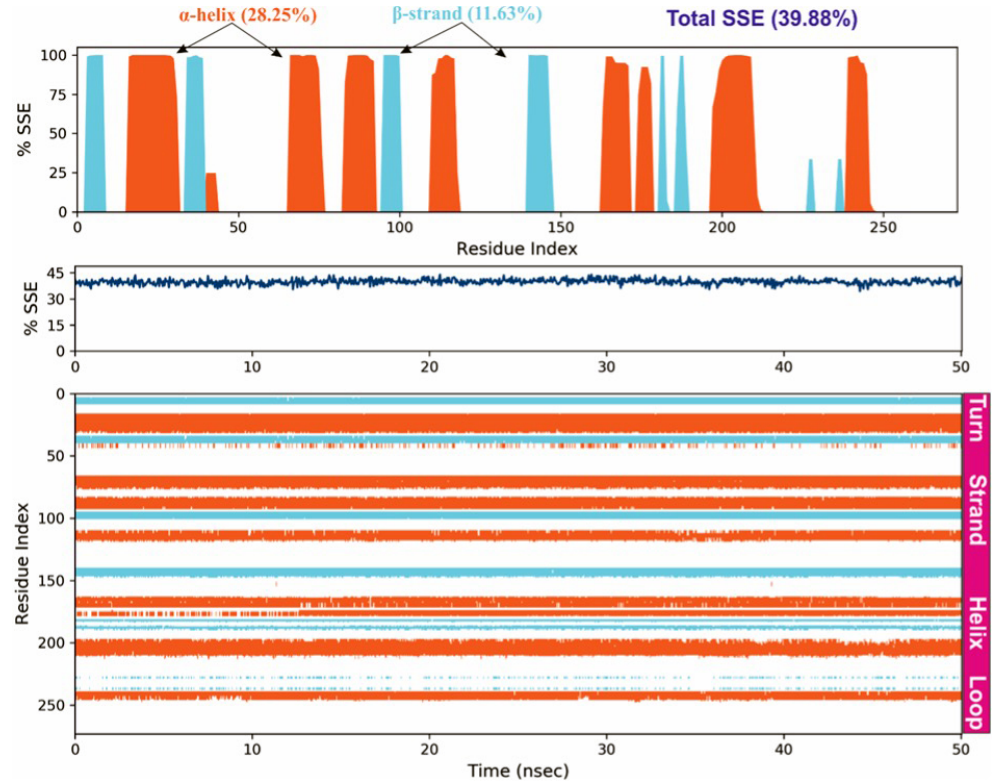
Figure 14. Protein secondary structure elements (SSE) like α -helices and β -strands are monitored throughout the simulation. The plot above reports SSE distribution by residue index throughout the protein structure.